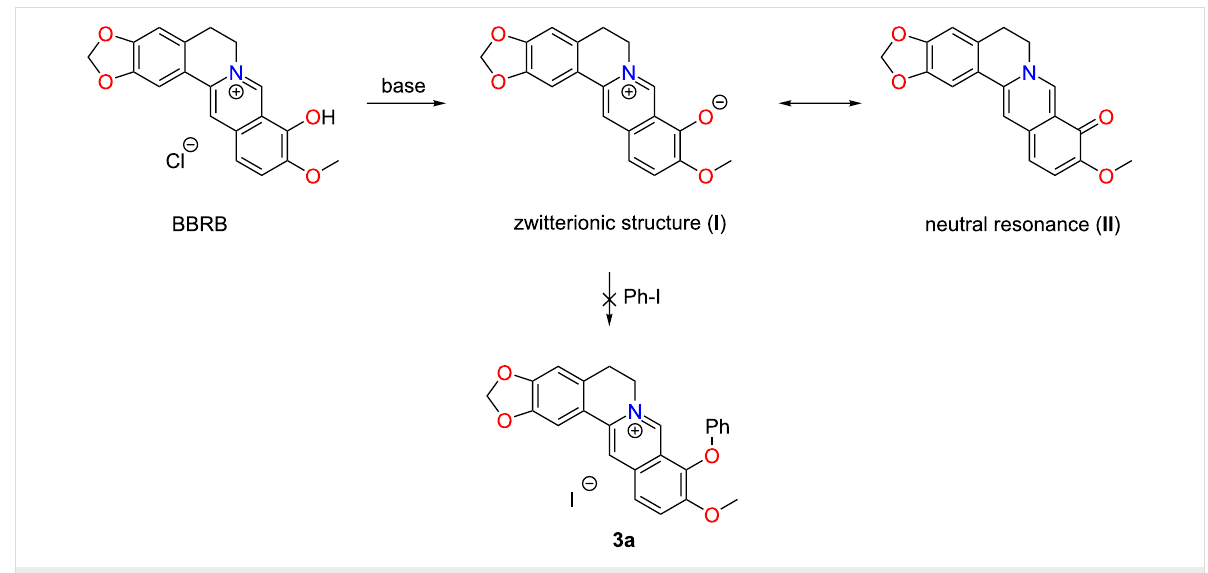
Scheme 2: Resonance of berberrubine leading to the failure of direct BBRB cross coupling.